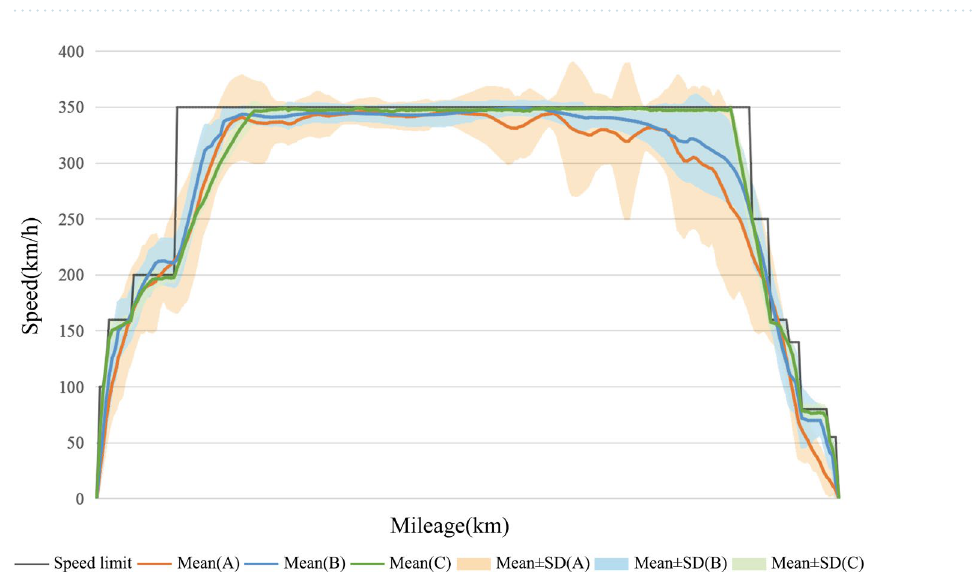
Figure 4. The train speed curve of groups A, B, and